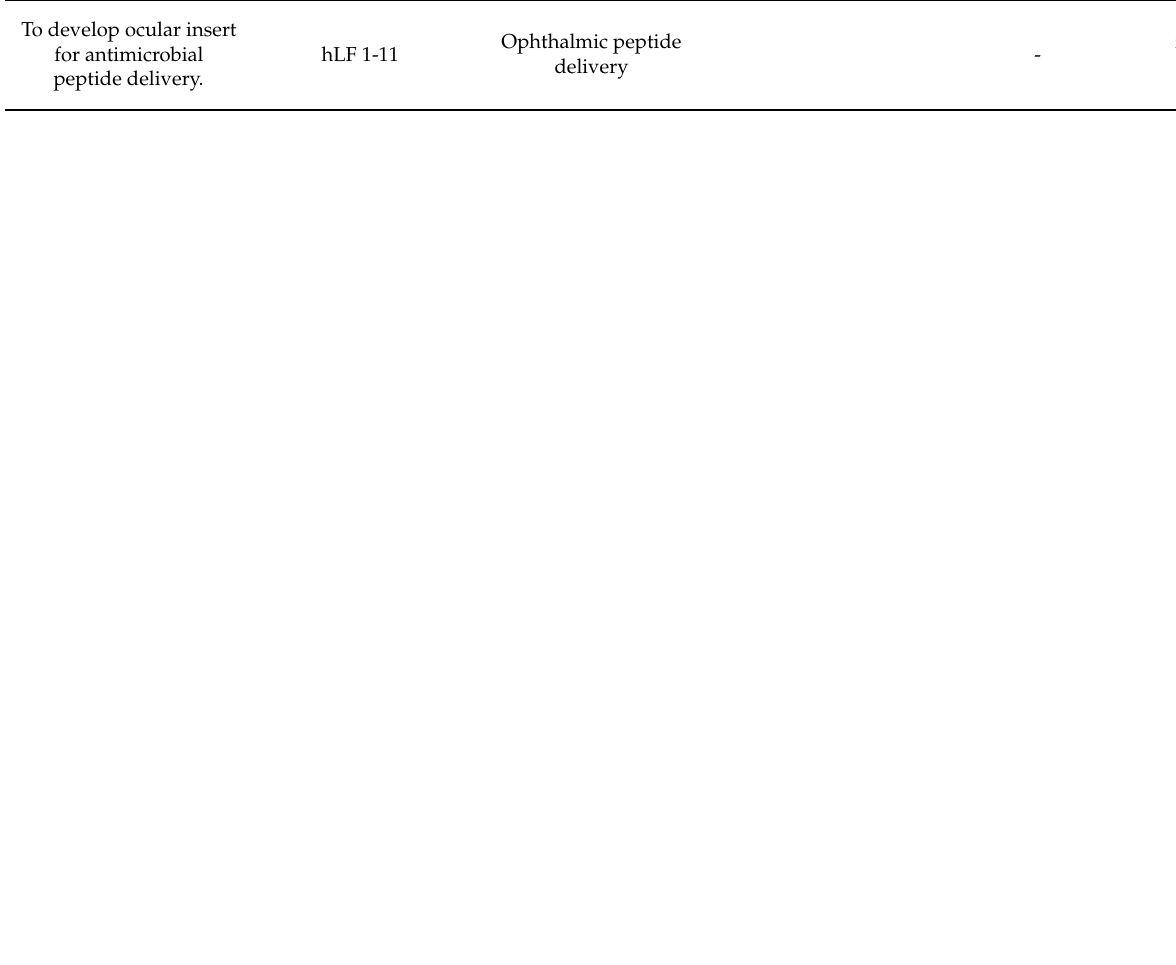
To evaluate the efficacy of 1% apoEdp against HSV-1 thymidine kinase (TK)-positive and HSV-1 TK negative